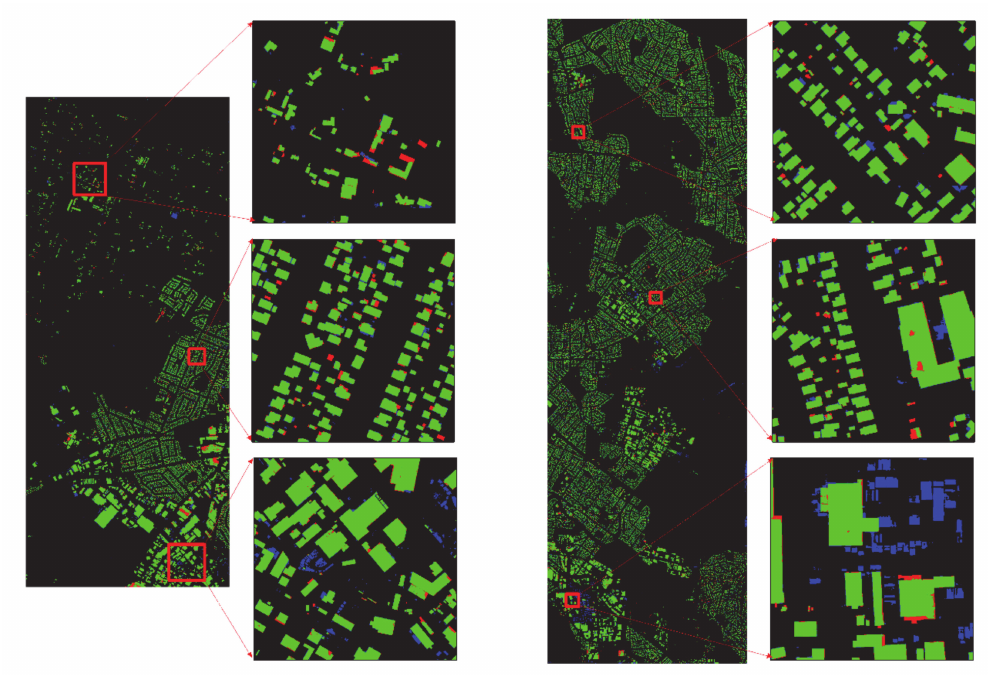
Figure A3. The performance of DR-Net with the dice coefficient loss and batch size set to 1 during training process, ( a , b ) show the building extraction result of the DR-Net on test A and test B area